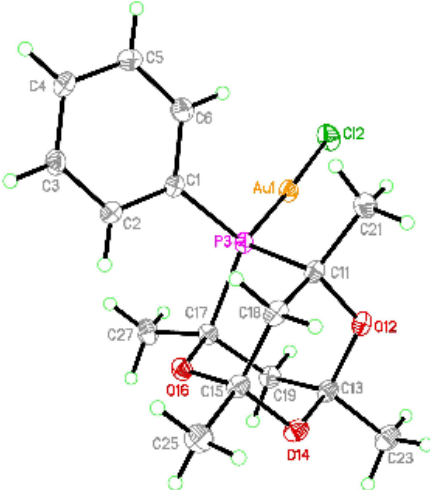
Figure 4. Structure of ( 3 ) with numbering scheme and thermal ellipsoids at 20% probability.